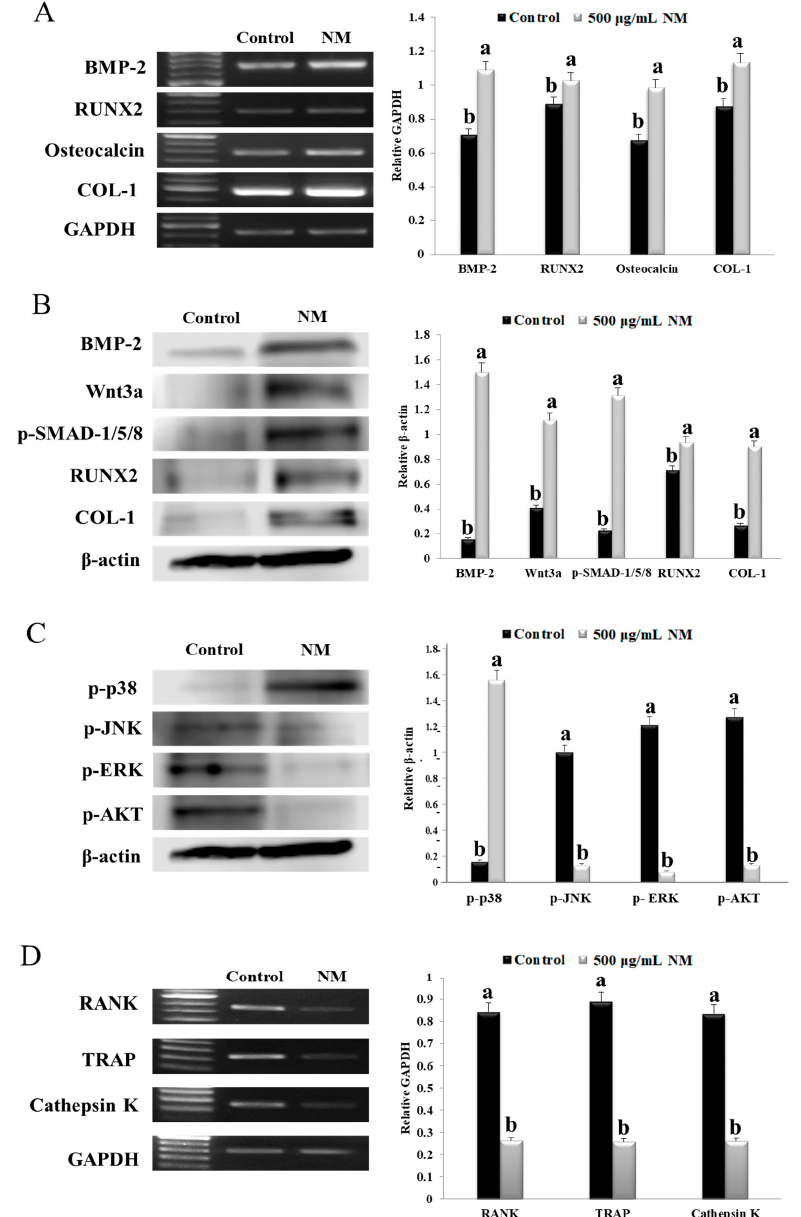
Figure 3. MG-63 osteoblast and RAW 264.7 osteoclast mRNA and protein expression levels of molecules involved in bone metabolism and signaling. ( A , B ) The cells were di ff erentiated for 4 days in di ff erentiation medium prior to reverse transcription PCR (RT-PCR) analysis of bone morphogenetic protein-2 (BMP-2), runt related transcription factor-2 (RUNX2), osteocalcin, and type 1 collagen (COL-1); mRNA levels and protein levels. ( C ) Levels of phosphorylated extracellular signal-regulated kinase (p-ERK), p-p38, phosphorylated serine / threonine kinase (p-AKT), and phosphorylated c-Jun N-terminal kinase (p-JNK) were determined by Western blot. ( D ) mRNA expression of receptor activator of nuclear factor kappa-B (RANK), tartrate resistant acid phosphatase (TRAP), and cathepsin K. The relative expression was quantified using ImageJ and calculated relative to glyceraldehyde 3-phosphate dehydrogenase (GAPDH) and β -actin. Results are expressed as the mean ± SD. Values not sharing a common superscript ( a , b ) di ff ered significantly (Duncan’s multiple range test) ( p <